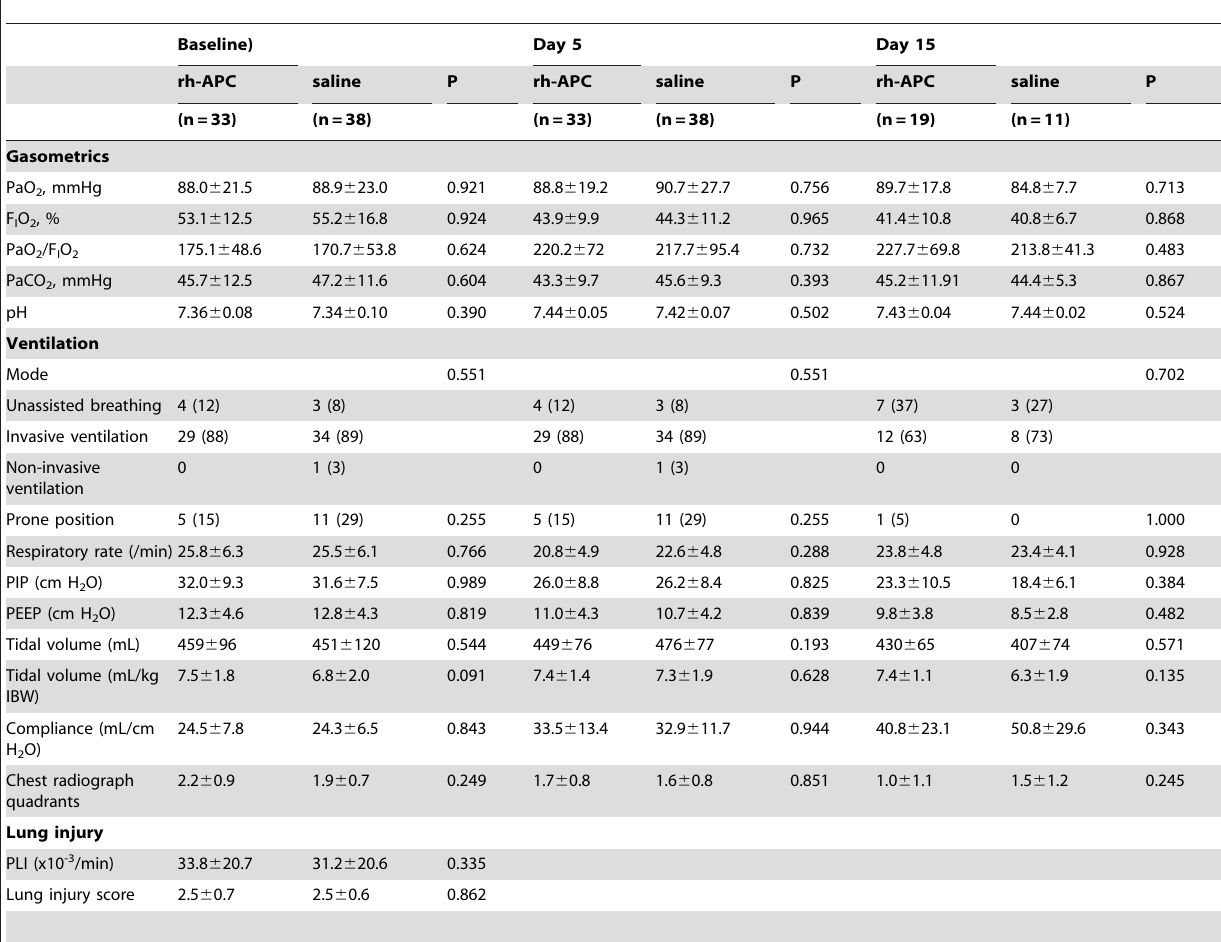
Table 2. Pulmonary